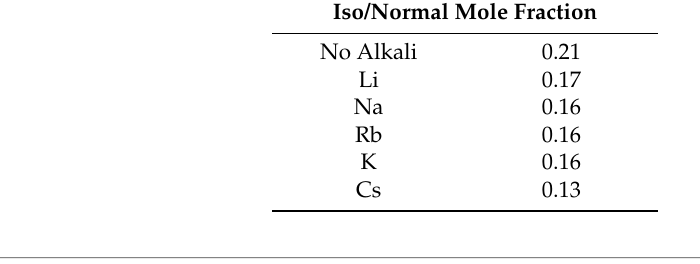
Table 5. A Comparison of the Isomerized to Normal Mole Fraction over a Series of Alkali Promoted Iron catalysts at low CO conversions (15–20%). Reactor Conditions: 270 °C, 12.1 bar, WHSV = 2, and H 2 /CO = 0.7.